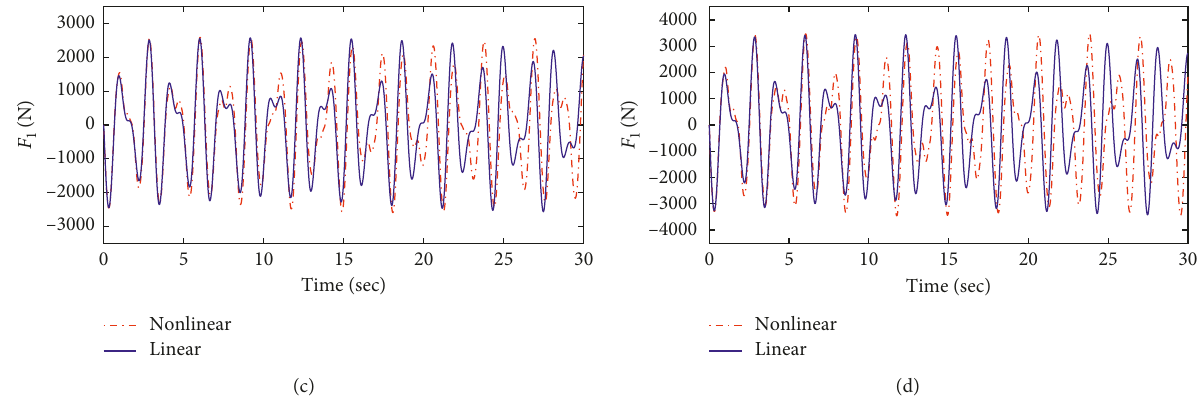
Figure 20: Time history of the resultant hydrodynamic force in the θ � 0 direction under the lateral harmonic excitation for ω � 6rad/s and X � 0.01m (a), 0.02m (b), 0.03m (c), and 0.04 m (d), respectively. 0